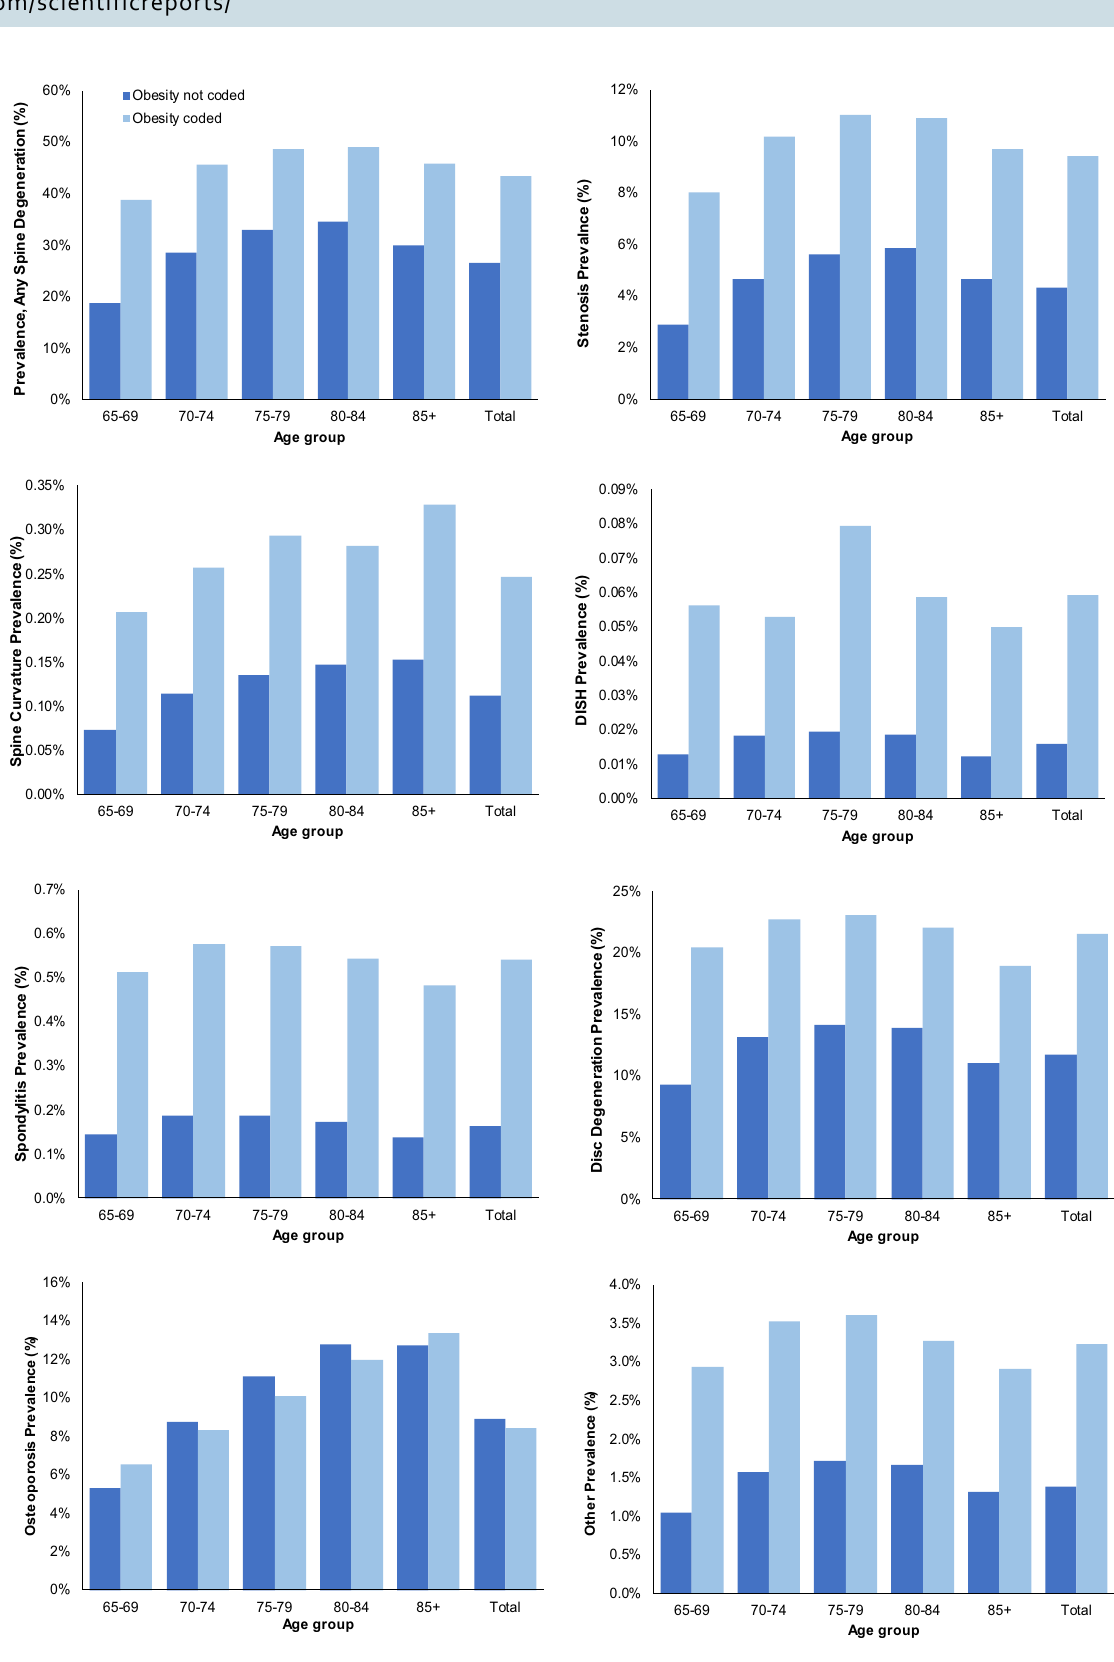
Figure 3. Spine degeneration diagnosis prevalence by type, age, and obesity